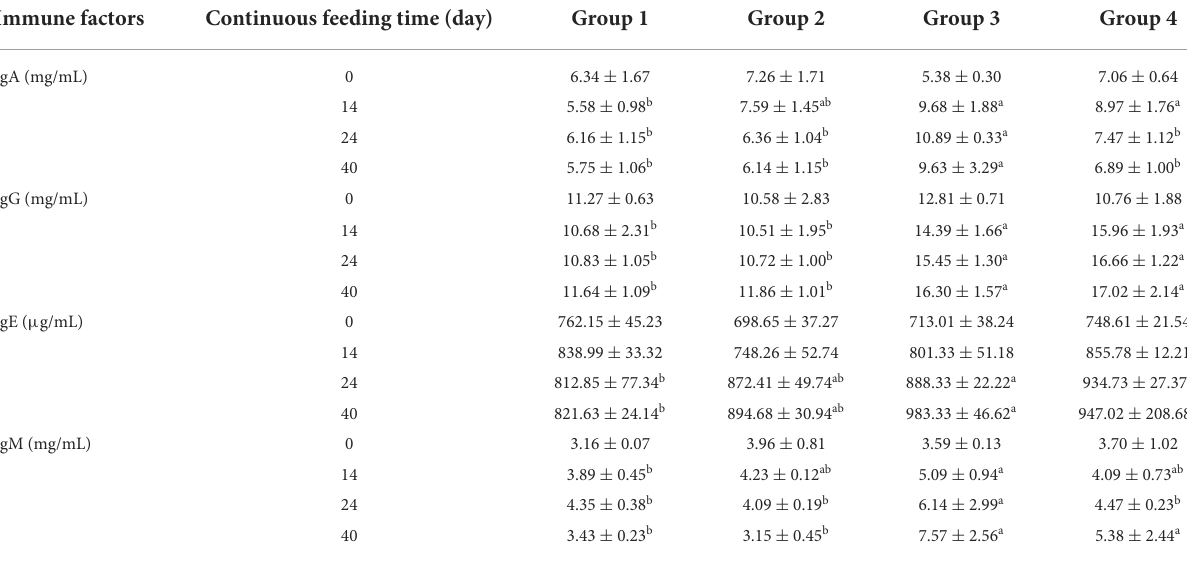
TABLE 6 Comparison of serum immunoglobulin levels (mean ± SD) among four treatment groups ( n = 5 in each group). Immune factors